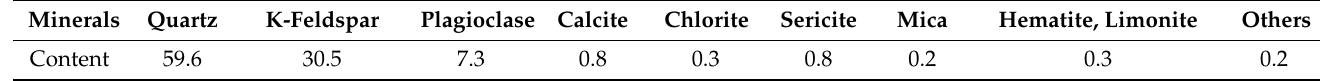
Table 7. Main mineral composition of desulfurized tailings (mass fraction, %).